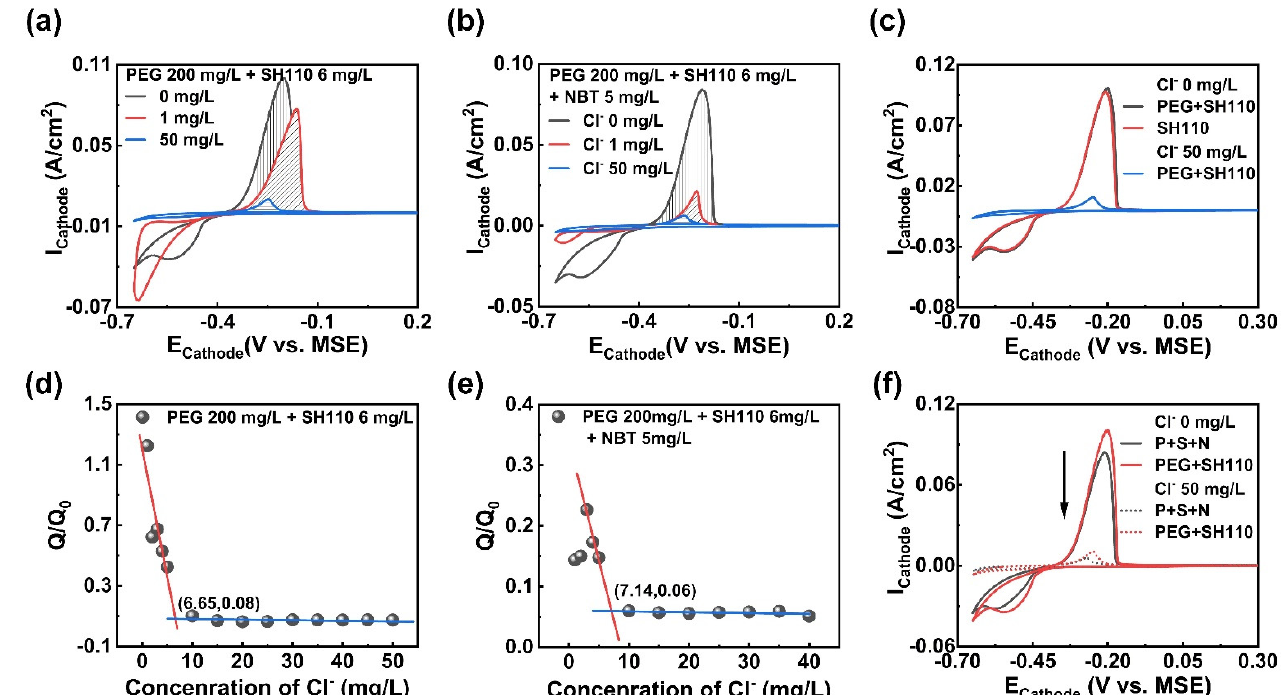
Figure 3. CV measurements of the electroplating solution containing: ( a ) PEG, 200 mg/L + SH110, 6 mg/L; ( b ) PEG, 200 mg/L + SH110, 6 mg/L + NBT, 5 mg/L; ( d , e ) Q/Q 0 as a function of Cl − concentration measured in ( a , b ); ( c , f ) CV curves comparison for different additives.